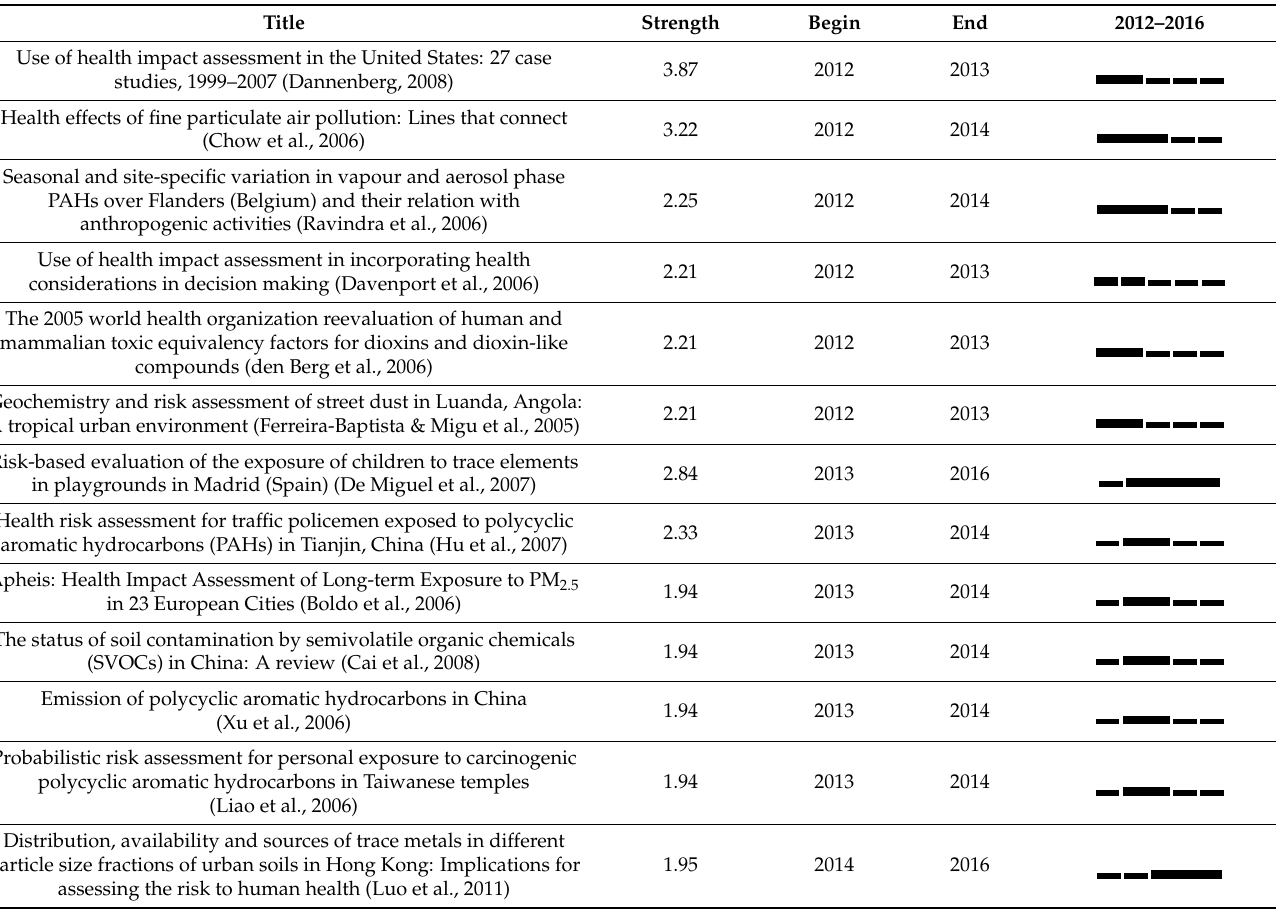
Table 6. Top 13 references with strongest citation bursts in 2012–2016. The black line represents the year of citation burstness of the